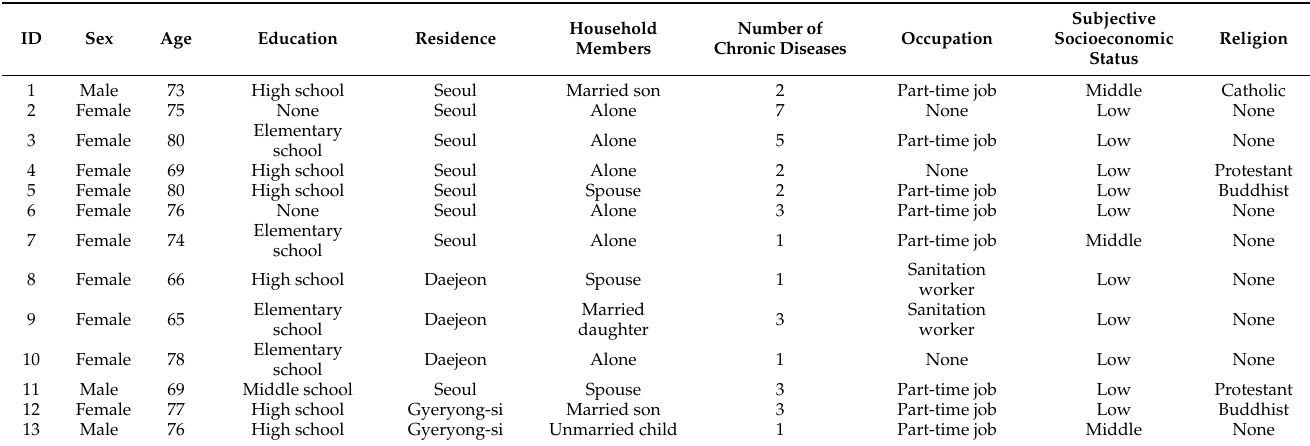
Table 1. General characteristics of